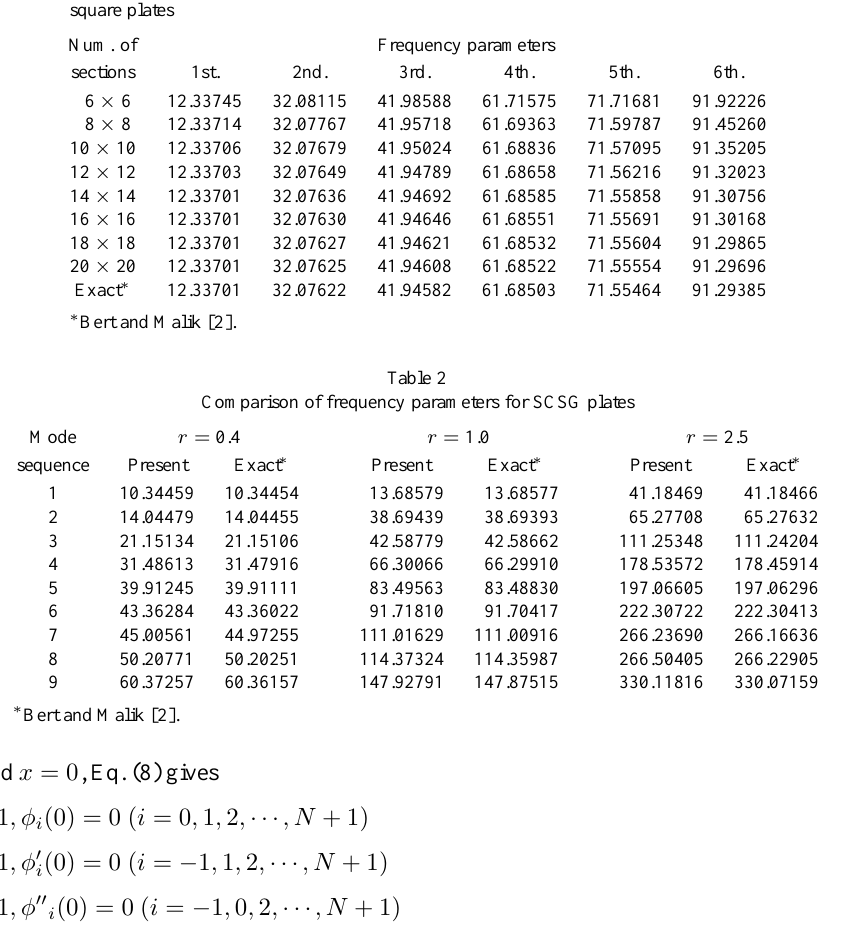
Table 2 Comparison of frequency parameters for SCSG